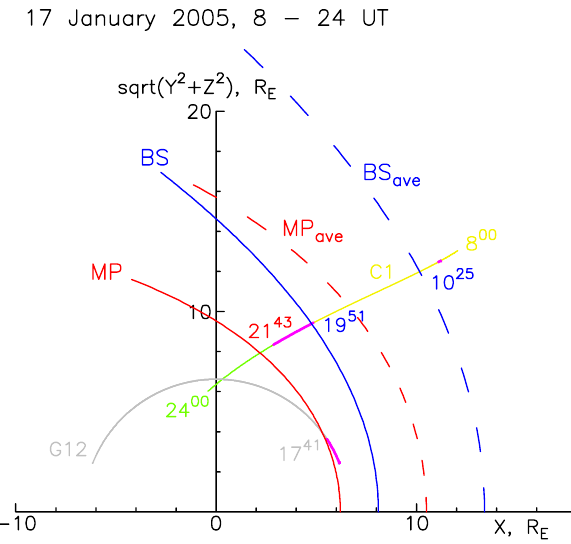
Fig. 2. Cluster 1 inbound trajectory and GOES 12 orbit in cylindri- cal coordinates. Sections in the magnetosheath are marked in lilac. Yellow sections: in interplanetary field. Green line for C1, gray line for G12: in magnetosphere. BS2 model (Cairns et al., 1995; Far- ris and Russell, 1994) bow shock is shown by blue line and MP1 model (Shue et al., 1998) magnetopause by red line: dashed curves for average solar wind parameters, solid curves calculated with pa- rameters around 17:40UT when G12 reentered the magnetosphere. Times of bow shock and magnetopause crossings are